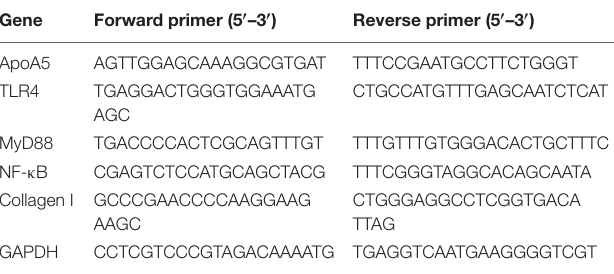
TABLE 1 | Primer sequences used for qRT-PCR.